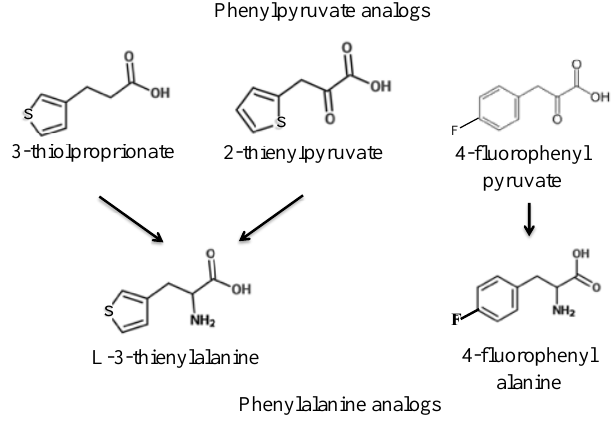
Figure 2. Analogs of phenylpyruvate and phenylalanine tested.